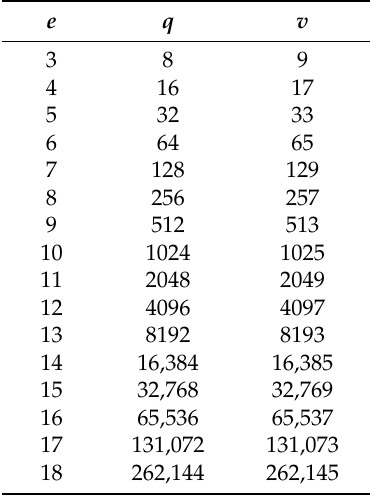
18. e  As a result, the